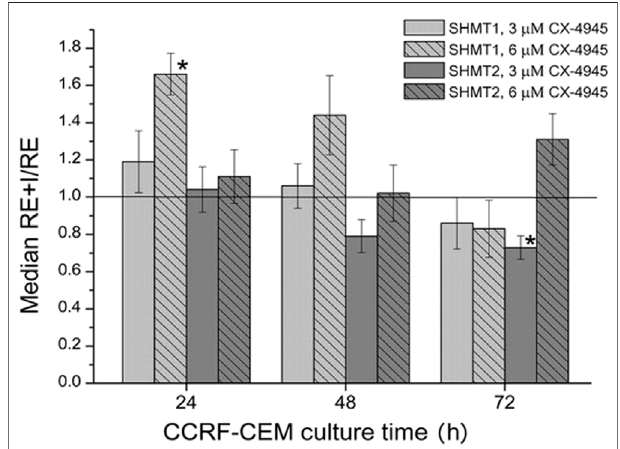
FIGURE 3 | The effect of CX-4945 on the mRNA level of cytosolic (SHMT1) and mitochondrial (SHMT2) serine hydroxymethyltransferases. The cells were treated with 3 μ M or 6 μ M CX-4945 for 24, 48, and 72 h. The RE + I/RE value equal to 1.0 means that the mRNA level in cells treated with theinhibitoristhesameasinuntreatedcells.Theasteriskindicatesstatistically signi fi cant